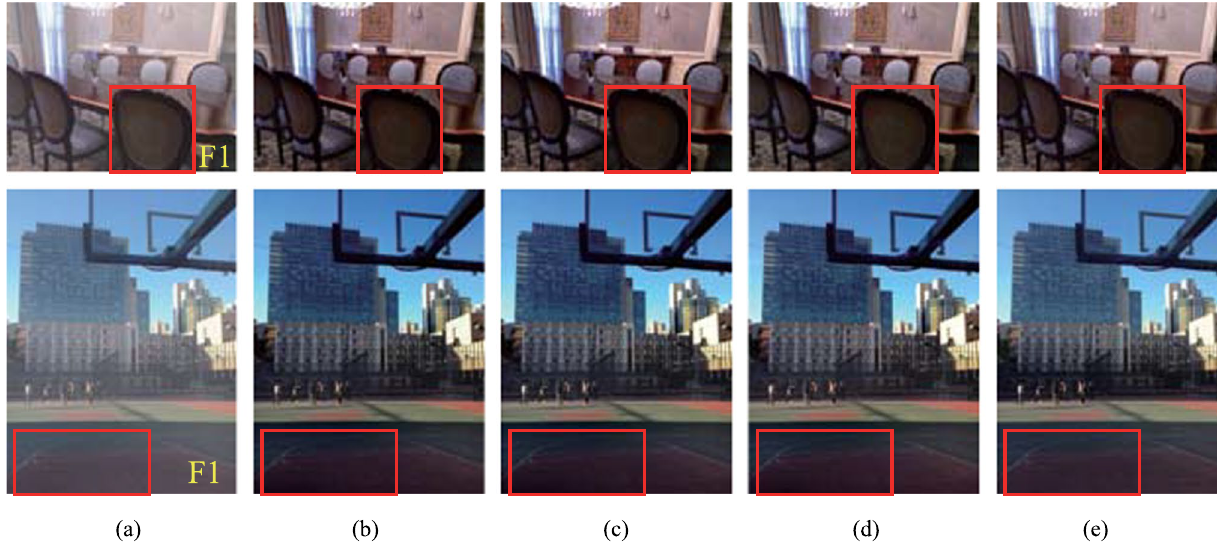
Fig. 9 Qualitative comparison between the proposed SZDNet and the other two methods (baseline and baseline + A(quad-tree)) in the two exam- ple images from SOTS Dataset. a Input hazy image. b Baseline. c Baseline + A(quad-tree). d SZDNet. e Ground-truth images